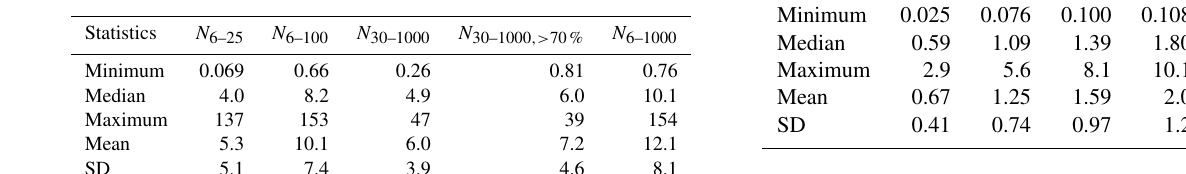
Table 1. Ranges, medians and means with SDs of the particle number concentrations in the diameter ranges 6–25nm ( N 6–25 ), 6– 100nm ( N 6–100 ), 30–1000nm ( N 30–1000 ), 30–1000nm if they con- tributed > 70% of all particles ( N 30–1000 ,> 70% ), and 6–1000nm ( N 6–1000 ); all values are in units of 10 3 cm − 3 .